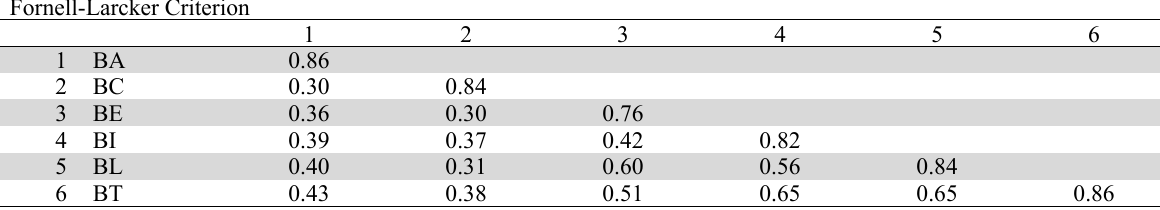
Discriminant validity (Fornell-Larcker criterion). Fornell-Larcker Criterion